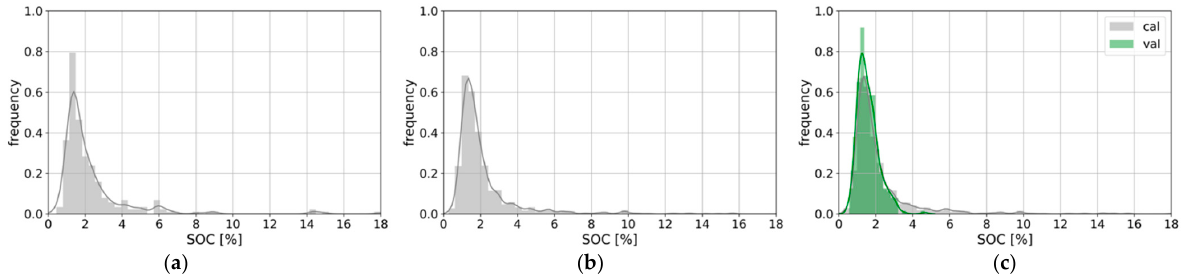
Figure 3. Frequency distribution of SOC contents of the ( a ) training, ( b ) test portion of the model calibration (cal) dataset and ( c ) a comparison of the model calibration dataset and the external independent validation (val) datasets.